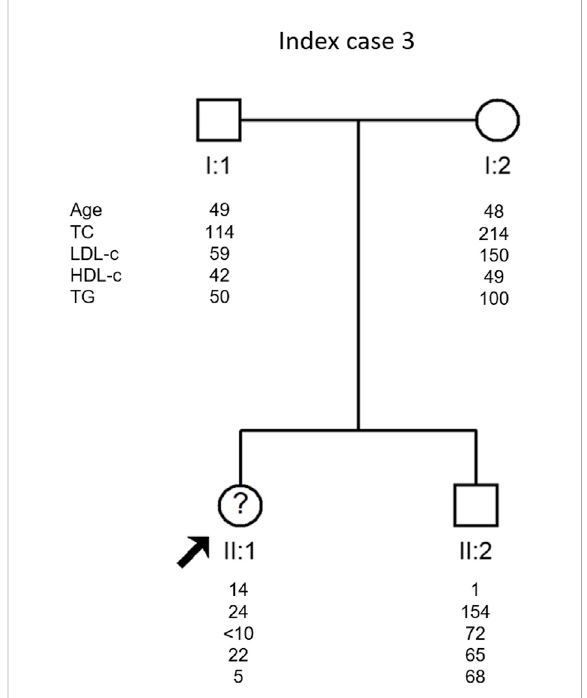
FIGURE 3 Arrow indicates index case 3 (IC3). Age (in years) and lipid pro fi le in mg/dL are under each